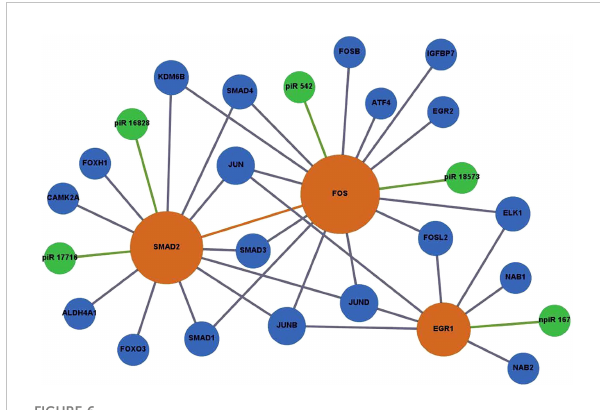
FIGURE 6 Network of DE piRNAs targeting pro fi brotic transcription factors during PHCF challenged with T. cruzi . Biological interaction networks were created using predicted piRNA targets (SMAD2, FOS, and EGR1) as primary seed nodes to query pathway and interaction data sources out to one degree of biological interaction. Primary seed notes are displayed as orange circles. Expansion notes (blue) with a predicted binding target of DE piRNAs